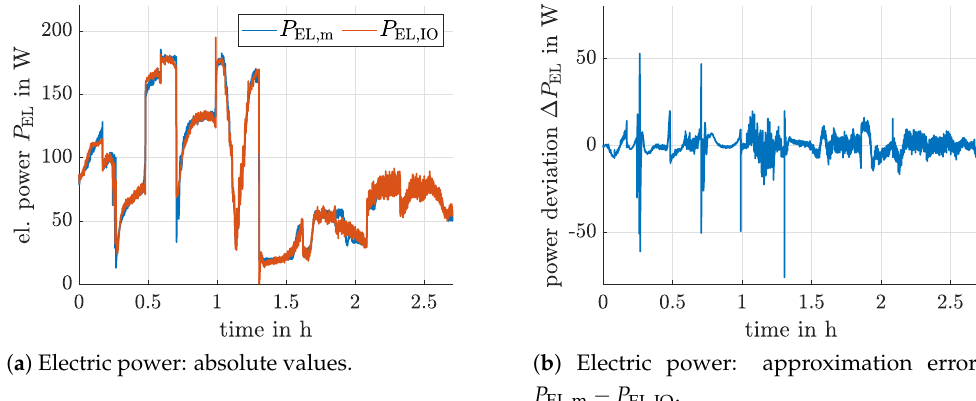
Figure 8. Comparison between measured and estimated stack power, P EL,m and P EL,IO , for the system model in Figure 7.